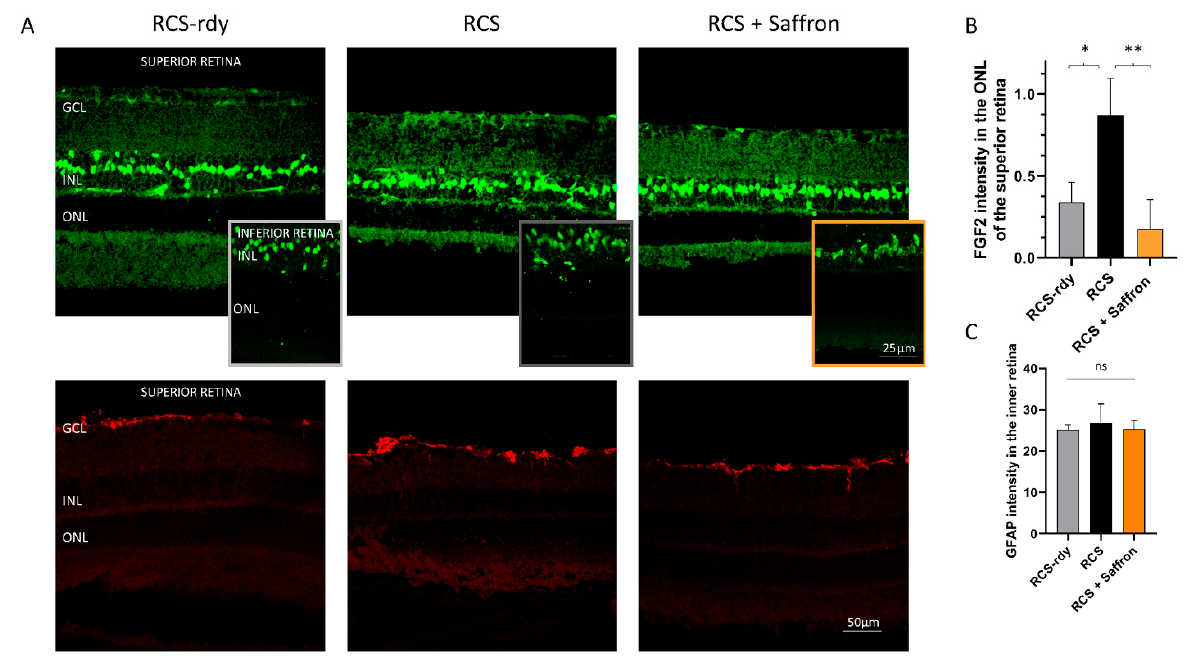
Figure 3. Impact of the of RCS Saffron treatment on the FGF2 and the GFAP expression. ( A ) Representative retinal images at P30, immuno-labelled against FGF2 (green) and GFAP (red). ( B ) FGF2 positive pixels in the ONL of treated, untreated, and control retinas; ( C ) GFAP analysis of treated untreated and control retinas. GCL: ganglion cell layer; INL: inner nuclear layer; ONL: outer nuclear layer ( n = 4; ± SEM; Statistical tests: One way ANOVA followed by Dunnett’s test) significance indicator: n.s. p > 0.05; * p < 0.05; ** p <